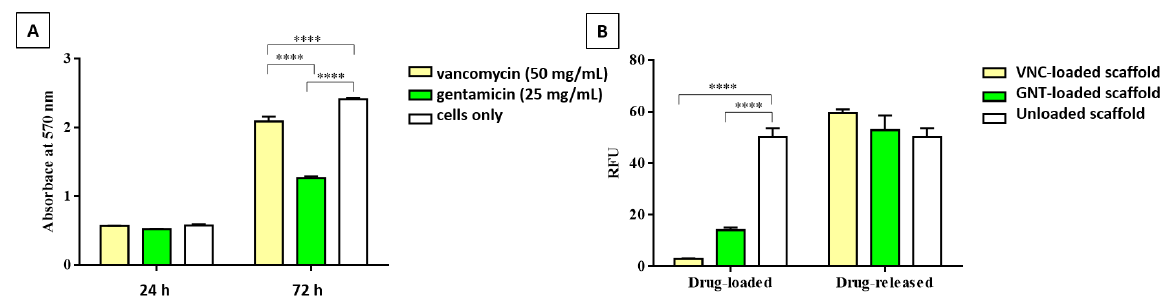
Figure 7. ( A ) MTT assay. Quantitative analyses of cell viability on 2D in vitro MG63 cell cultures in the presence of free vancomycin and gentamicin after 24 and 72 h of culture. (**** p -value ≤ 0.0001). ( B ) PrestoBlue™ Cell Viability Reagent. Quantitative analysis of MG63 viability, cultured one day on the 3D medicated-MgHA/Coll scaffolds. (**** p - value ≤ 0.0001).